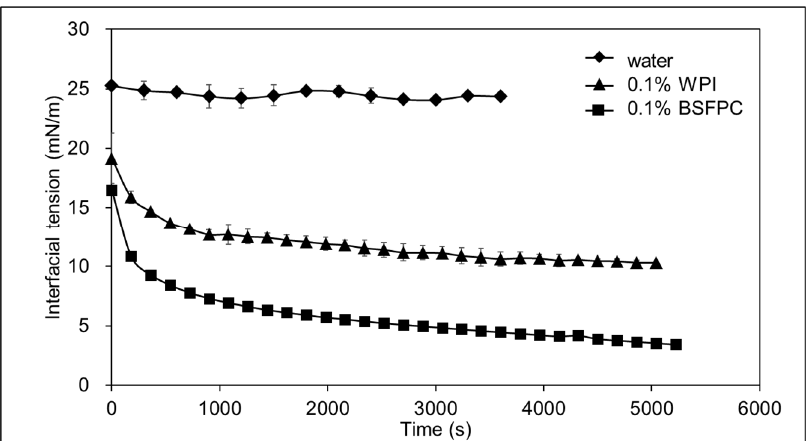
Figure 5. Interfacial tension between aqueous solutions of water, 0.1% WPI (whey protein isolate) and 0.1% BSFPC (black soldier fly protein concentrate), respectively, and sunflower oil (25